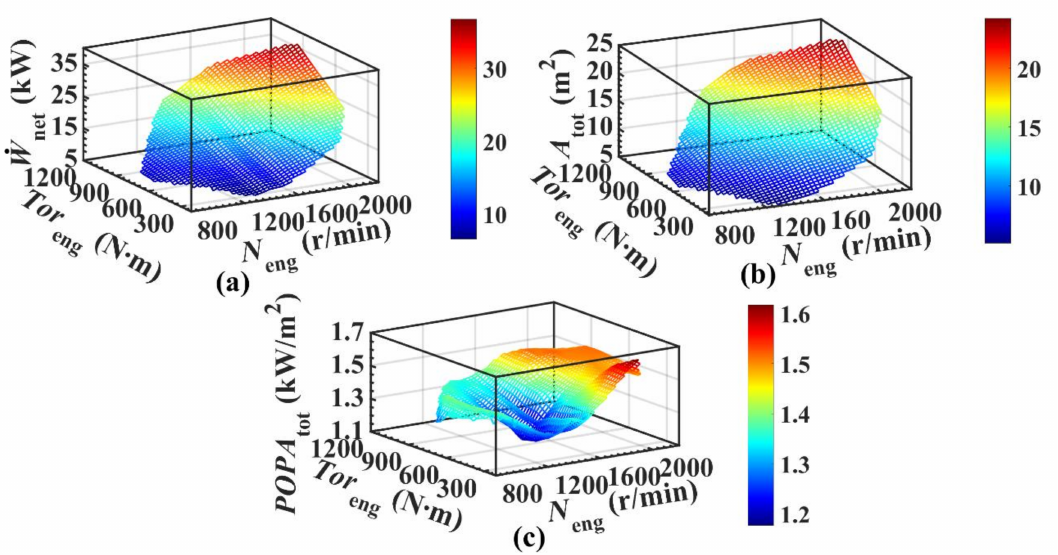
Figure 8. Dynamic response characteristics of system POPA under full operating conditions. ( a ) dynamic response characteristics of the net power output of the system. ( b ) dynamic response characteristics of the heat transfer area of the system. ( c ). dynamic response characteristics of the system POPA.